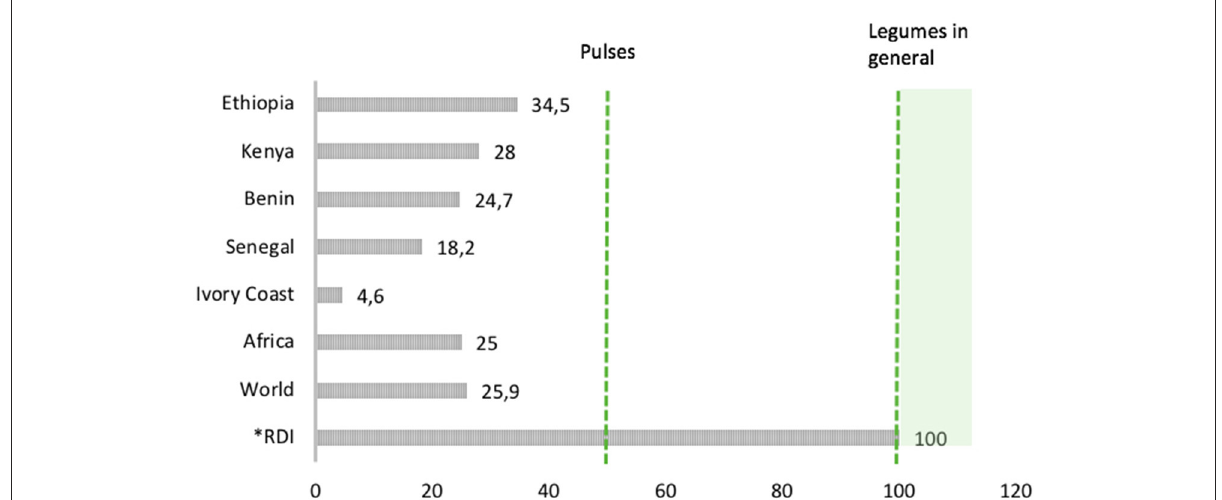
FIGURE1 Legume intake (g/day/capita) in adults aged > 20 years. Data source: Global Dietary Database (2019), *TMREF: Theoretical minimum risk of exposure level; the optimal dietary intake that minimizes risk from all causes of deaths combined. For legume intake, TMREF is 100 g/day including 50g pulses, 25g soy foods, 25 g peanut (Willett et al.,